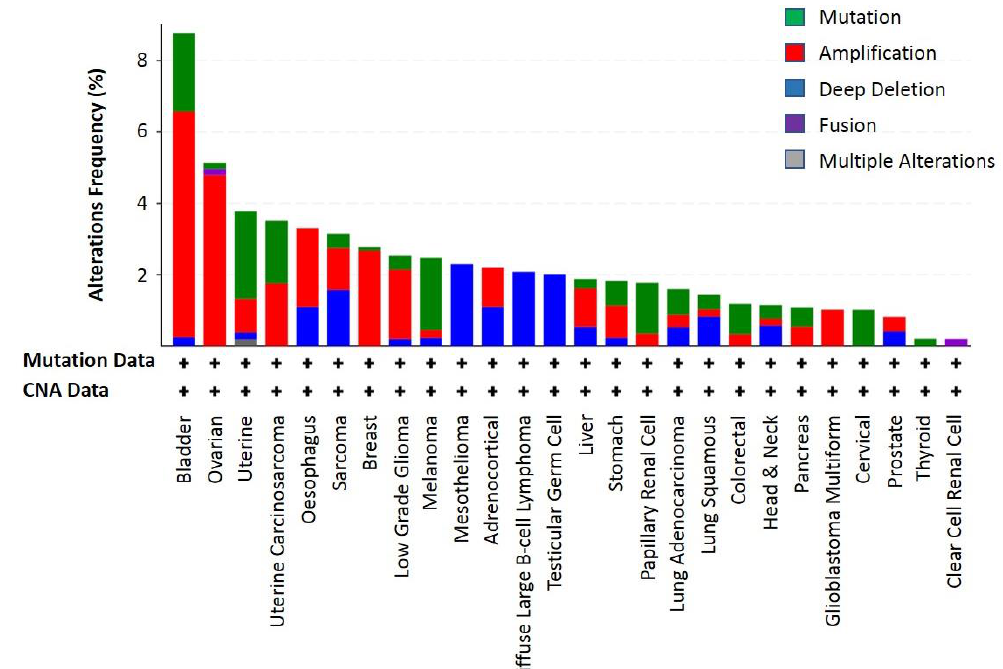
Figure 7. The frequency of KLF6 genetic alterations in twenty-six different cancer types that were molecularly characterised in the large scale TCGA project. These KLF6 genetic alterations frequency data were queried and extracted using cBioPortal (https://www.cbioportal.org/) [108,109]. The identified genetic alterations in KLF6 include mutation, amplification, deep deletion, fusion and multiple alterations. The “+” sign on top of each cancer type indicates that the mutation and copy number alteration (CNA) data are available for these cancer types.